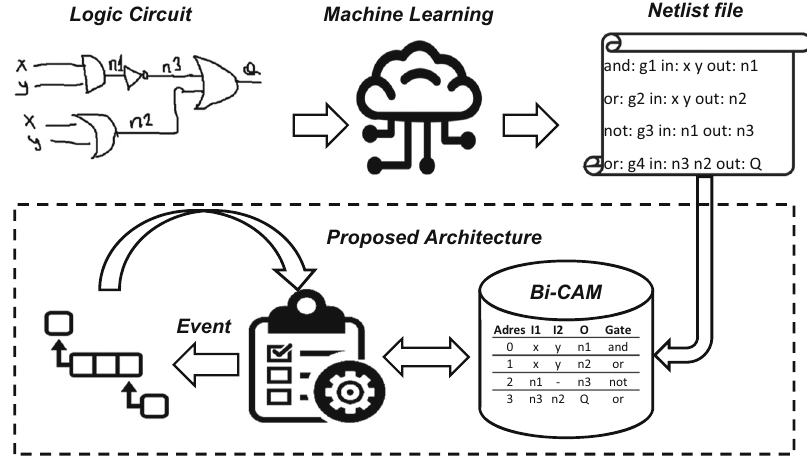
Figure 4: Overview of the proposed architecture.